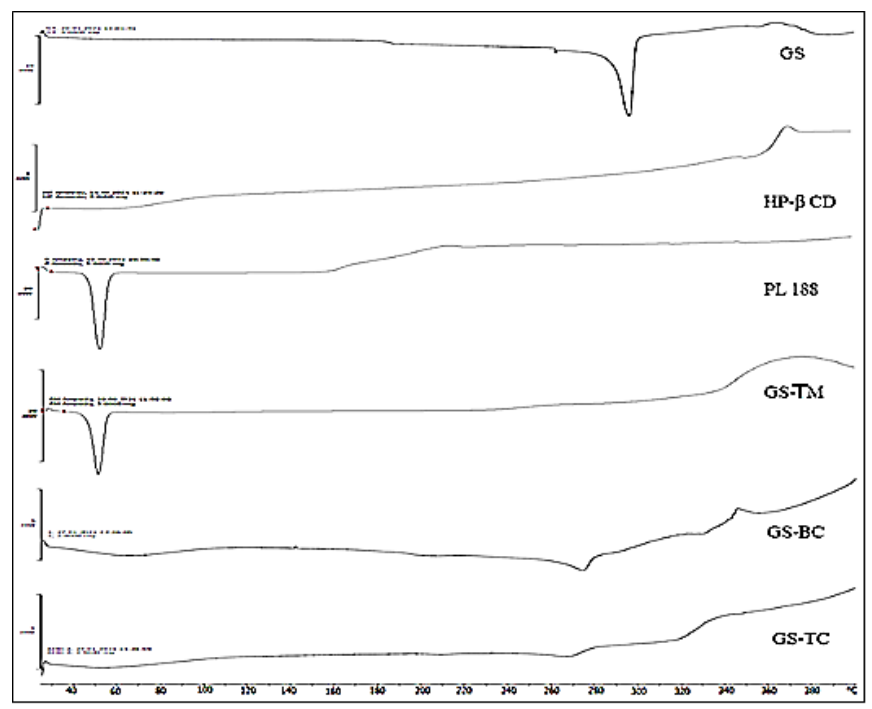
Figure 6. DSC thermogram of Genistein, HP β CD, poloxamer 188, genistein ternary mixture (GS TM), genistein binary complex (GS BC) and genistein ternary complex (GS TC).